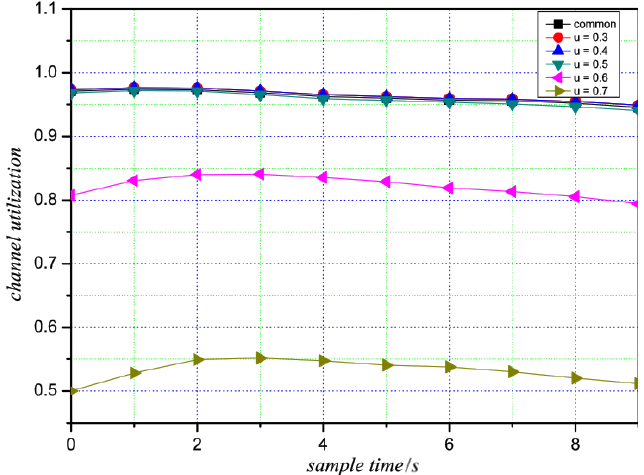
Figure 11. Channel utilization compared by different values of µ